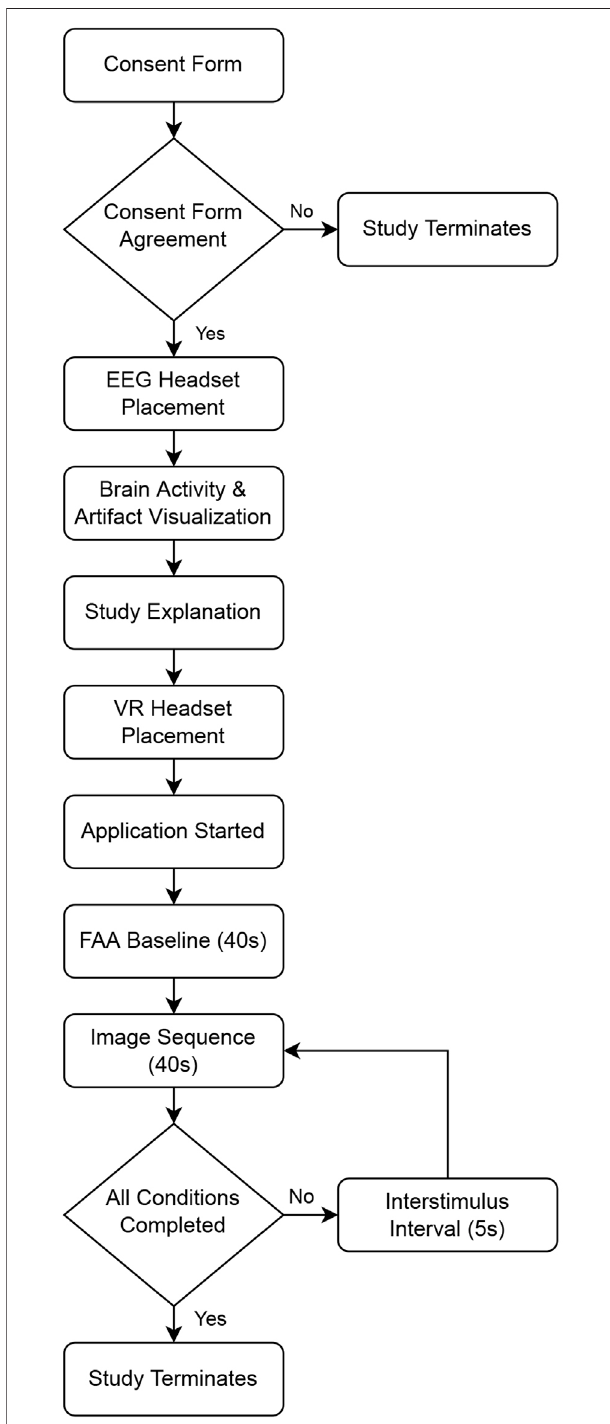
FIGURE 5 | Flowchart of study